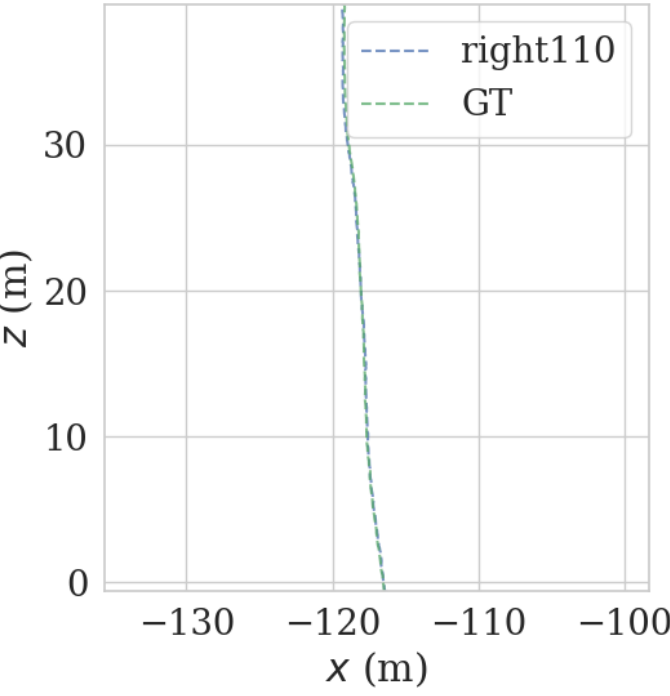
Figure 22. Track error using front-right LiDAR data on the straight